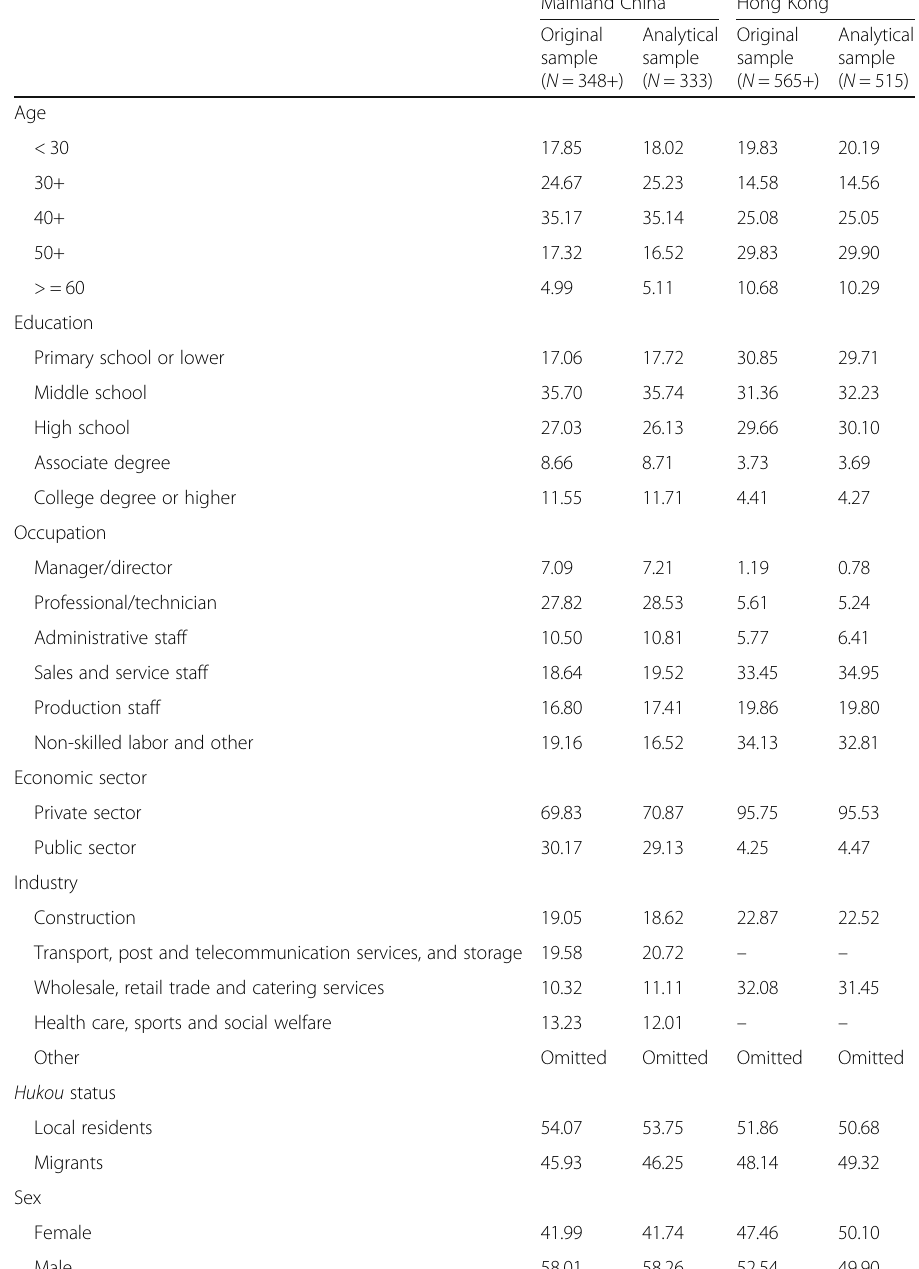
Mainland China Hong